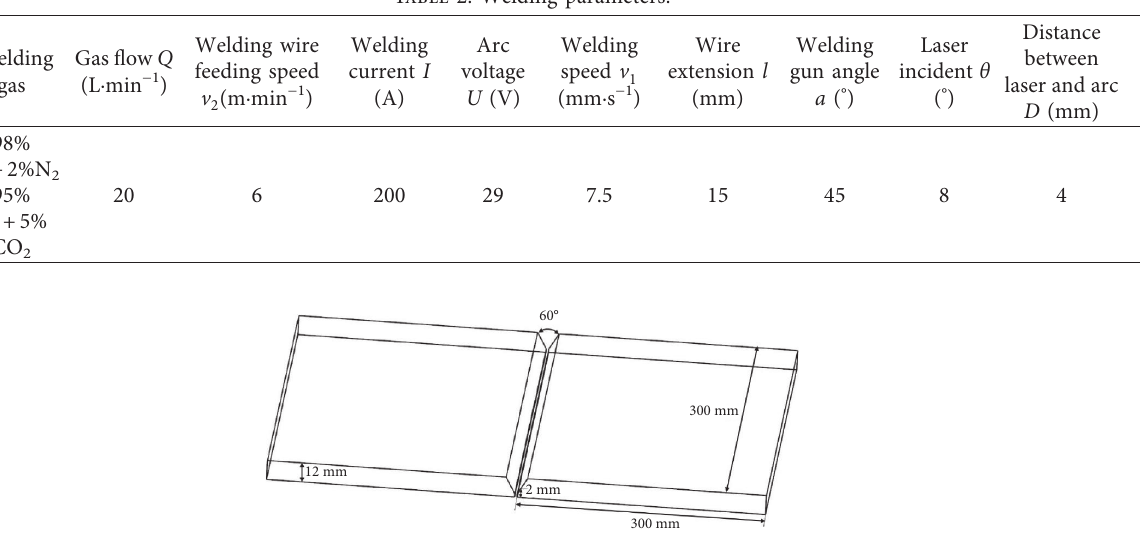
Figure 2: Schematic diagram of prewelding test plate